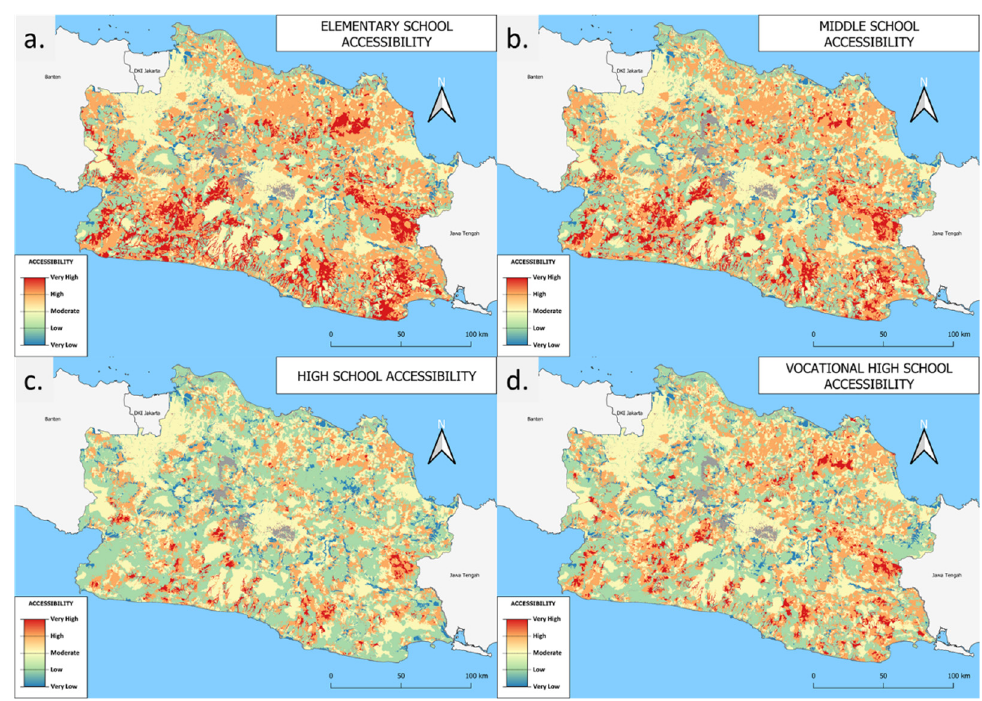
Figure 6. School accessibility for: ( a ) elementary, ( b ) junior high, ( c ) senior high, and ( d ) vocational high schools.